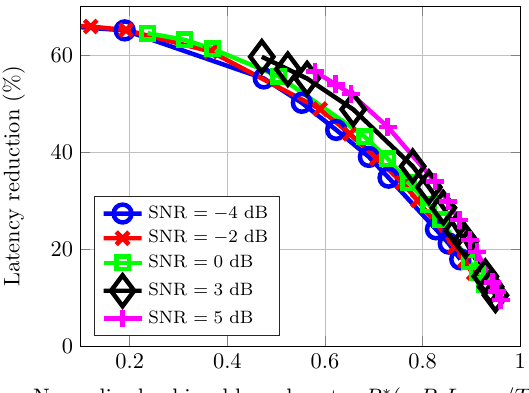
Fig. 11 Latency reduction for normalized achievable code rates with various SNR link budgets. The number of hops h = 5 , and the BLER ǫ = 10 −